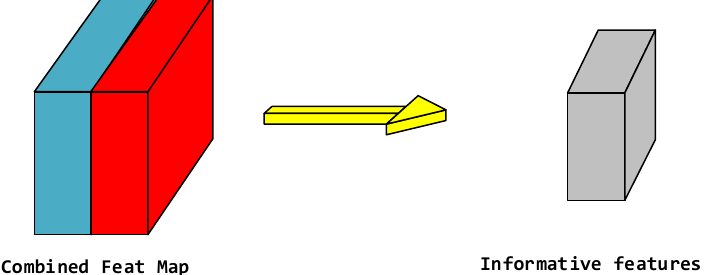
Figure 2. Combined feature map.